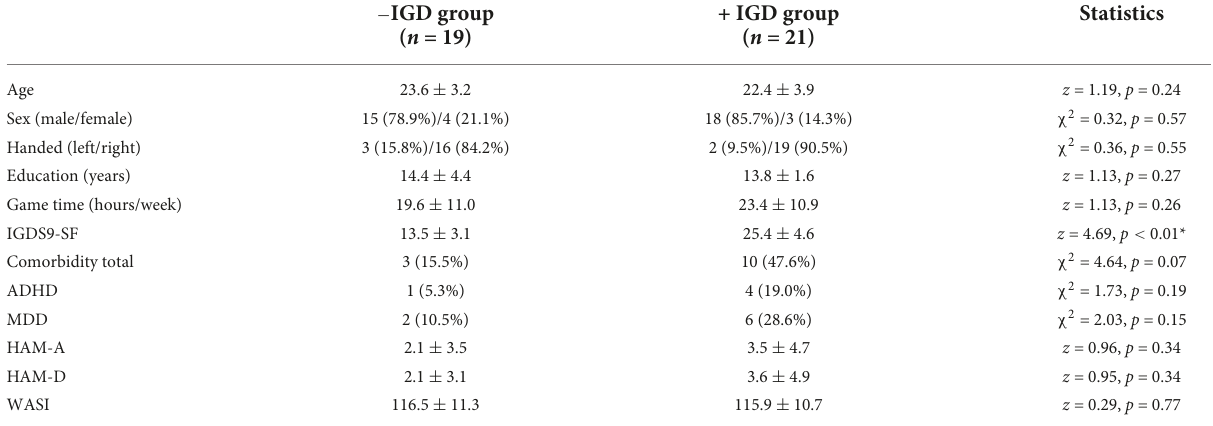
TABLE 1 Demographic and psychological